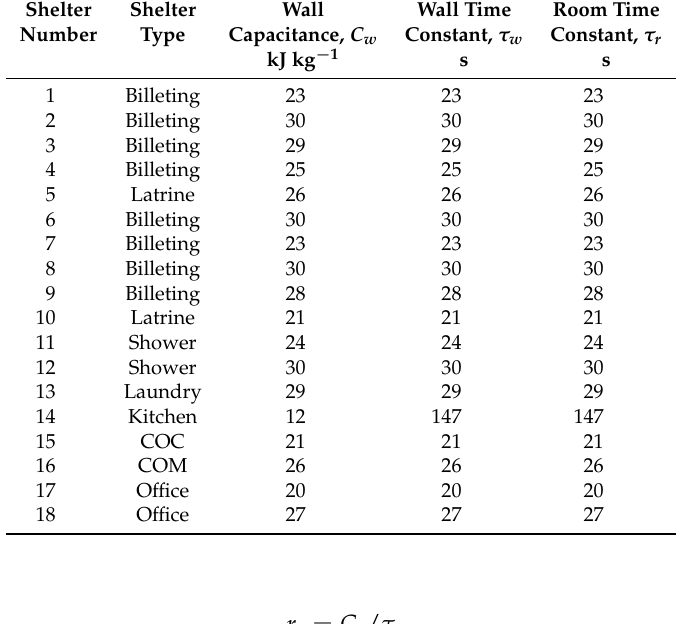
Table A2. Shelter-specific thermal